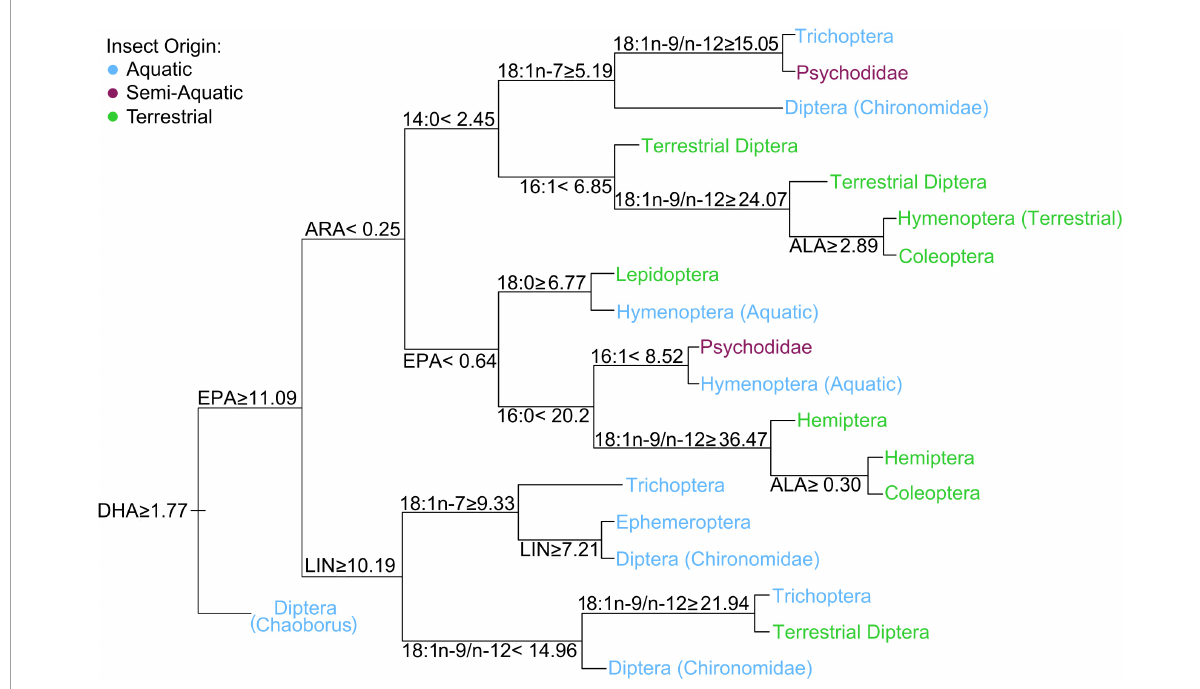
FIGURE3 Regression tree analysis constructed with individual fatty acids (% of total FA) that were significant in the similarity percentages (SIMPER) analysis. All insect orders were considered, however, only those separated by the selected FA are shown. The condition set at each node is true for the divide going downwards and the opposite condition is true for the divide going upwards. Fatty abbreviations: linoleic acid (LIN; 18:2n-6), α -linolenic acid (ALA; 18:3n-3), arachidonic acid (ARA; 20:4n-6), eicosapentaenoic acid (EPA; 20:5n-3), and docosahexaenoic acid (DHA;